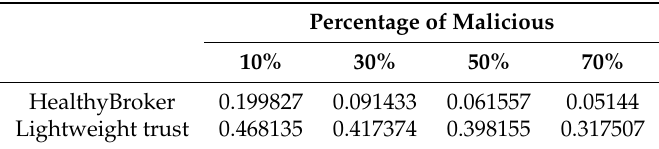
Table 1. Mean absolute deviation (MAD) results with naïve malicious.